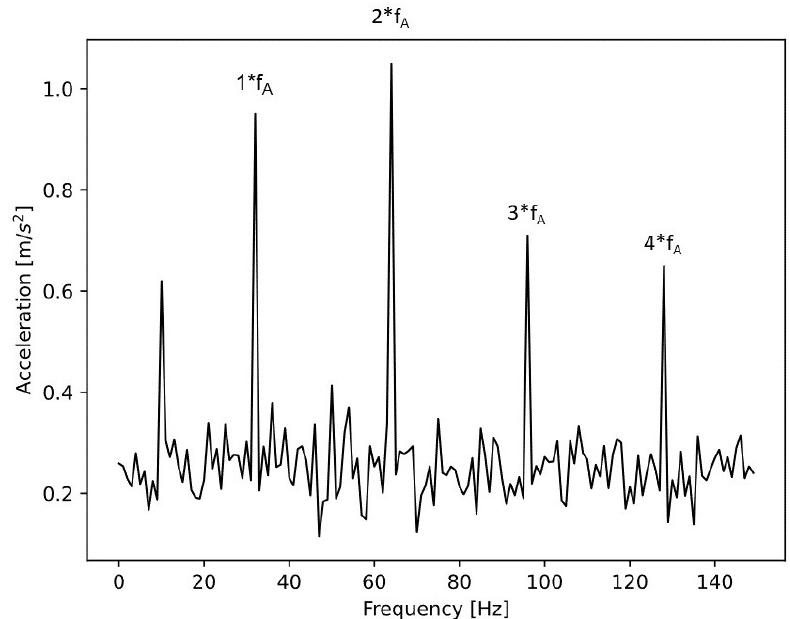
Figure 2. Envelope curve spectrum of a ball bearing with advanced outer ring damage. The characteristic line of a damaged inner ring is completely different. The Sidebands are distributed around the rollover frequency ( f I ) of the inner ring and its multiples with the distance of f n (the rotor rotational frequency), see Figure 3. The rollover frequency can be calculated with the formula below with the rotational frequency of the rotor, f n ; the number of rolling elements, Z; diameter of the rolling element, D W ; contact angle, α ; and pitch circle diameter, D PW [16]: